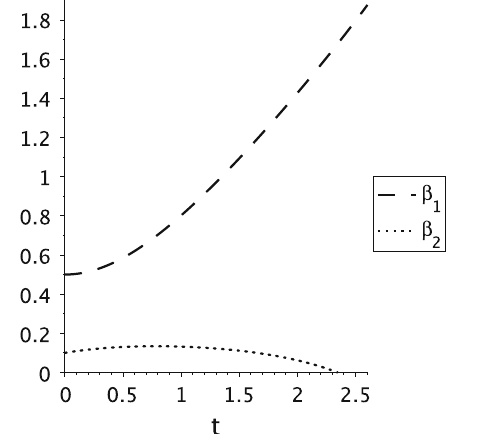
Fig. 3 The same as in Fig. 1 except ˙ β 2 ( 0 ) = 0 . 1